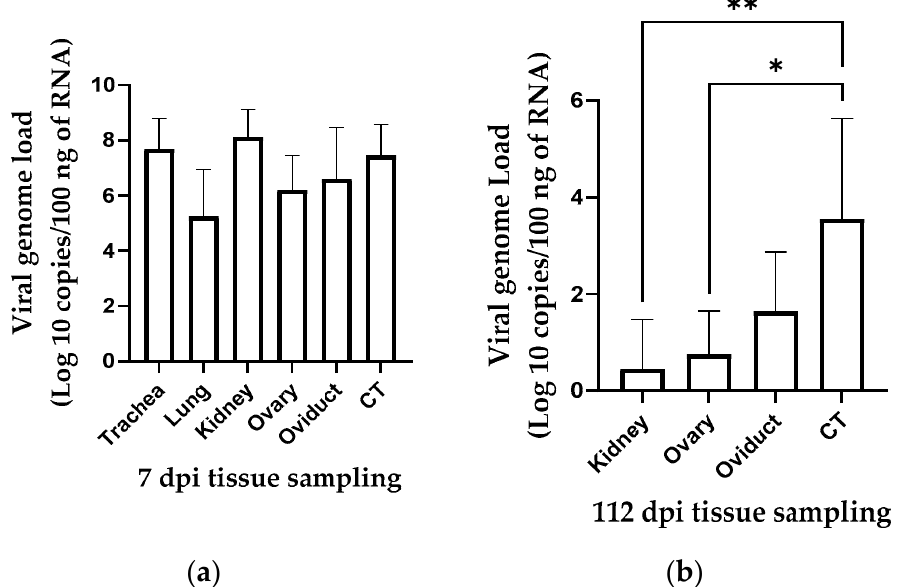
Figure 3. IBV genome loads in different tissue samples collected at 7 dpi ( a ) and 112 dpi ( b ) following infection at 1-day of age. The average starting IBV copies was quantified per 100 ng of the extracted RNA and differences between tissue samples at both time points were compared using Friedman test followed by Dunn’s multiple comparisons test, and the error bars represent the SD. Statistical significance: * p < 0.05, ** p <